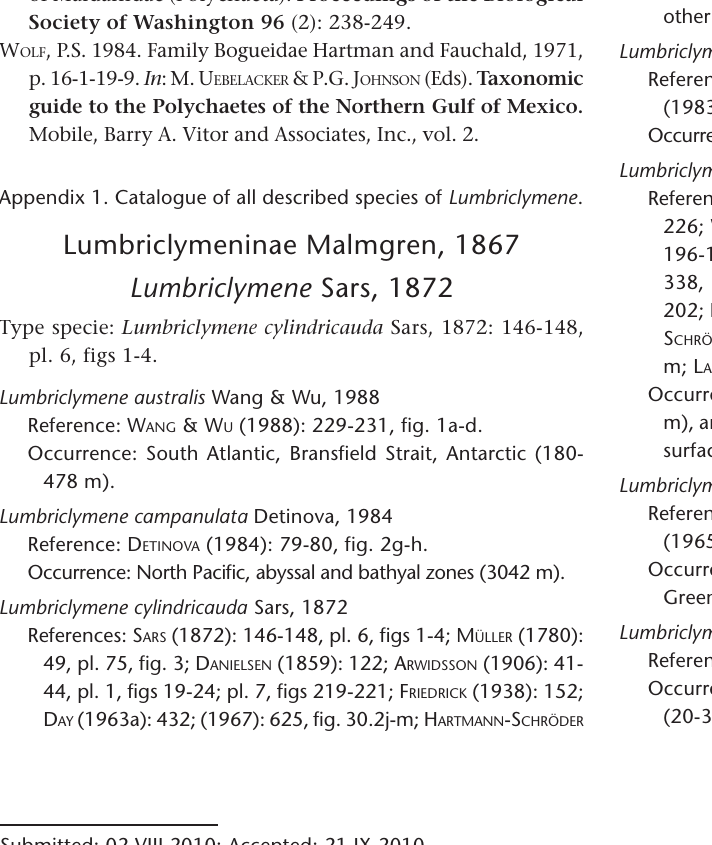
fig. 5: I MAJIMA & S HIRAKI (1982): 26-28, figs 9a-m and